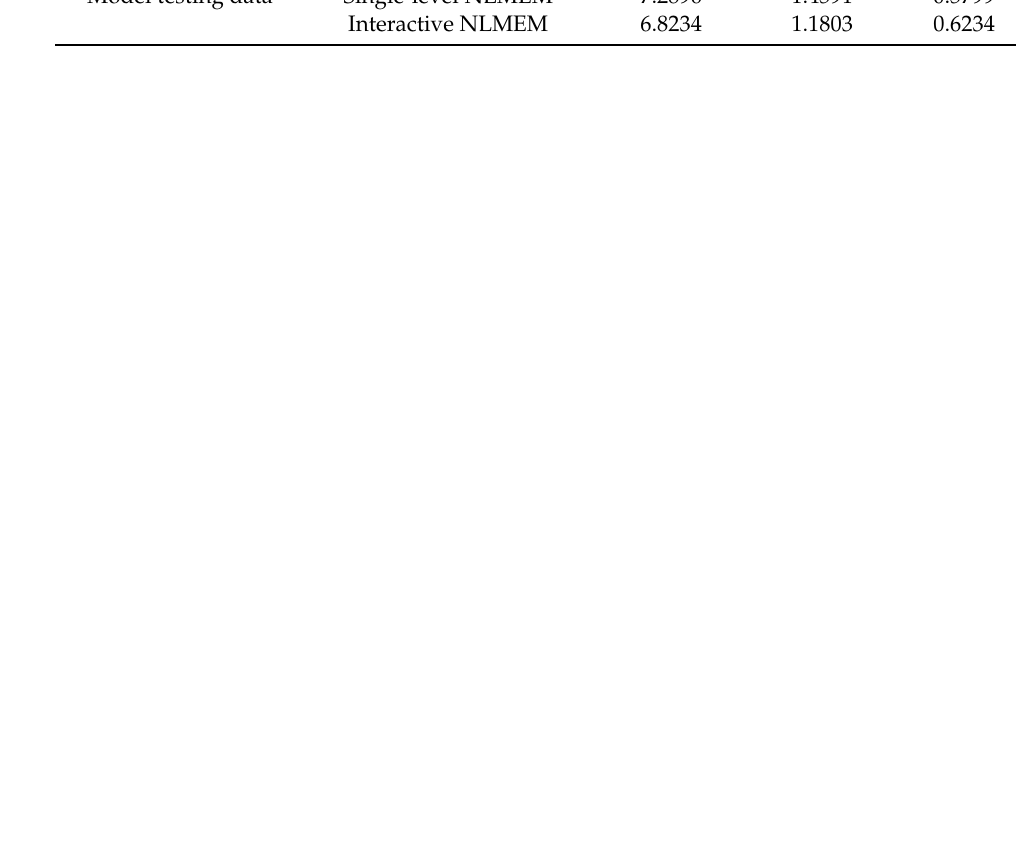
Figure 4. Residual distributions of NLS model (Equation (12), the single-level NLME model (Equation (14)), and the inter- active NLME model (Equation (13) for both the model fitting data and model testing data, respectively.